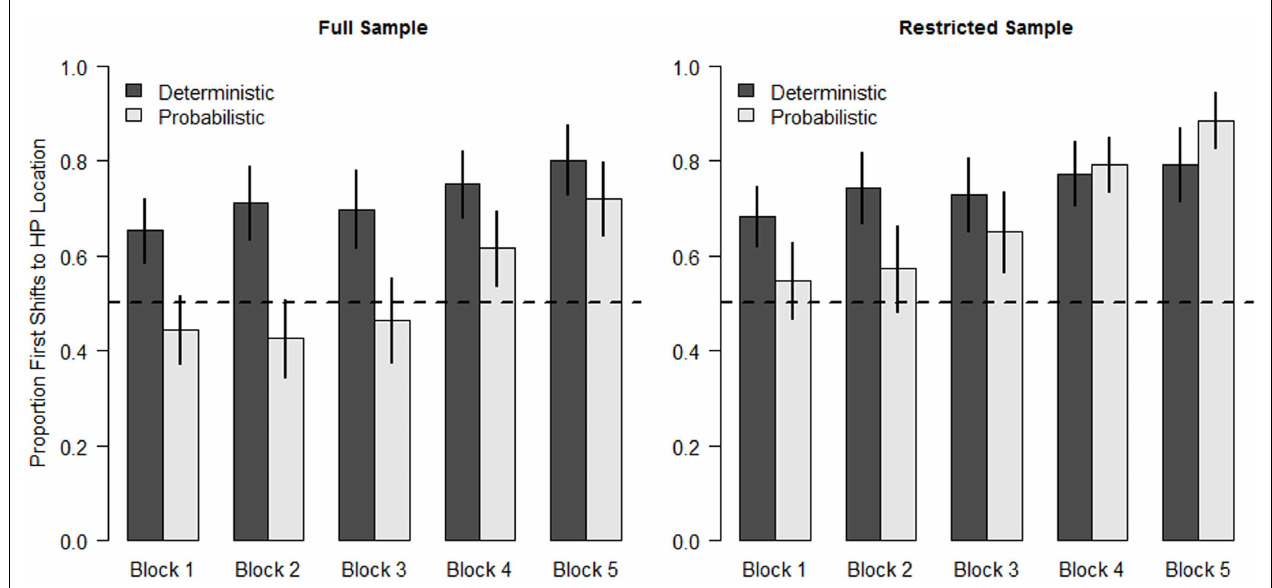
FIGURE 2 | Proportion of anticipatory shifts to the High Probability location in each condition. Error bars are standard error of the mean.The left panel shows results from all infants, the right panel includes only the restricted sample (see text).